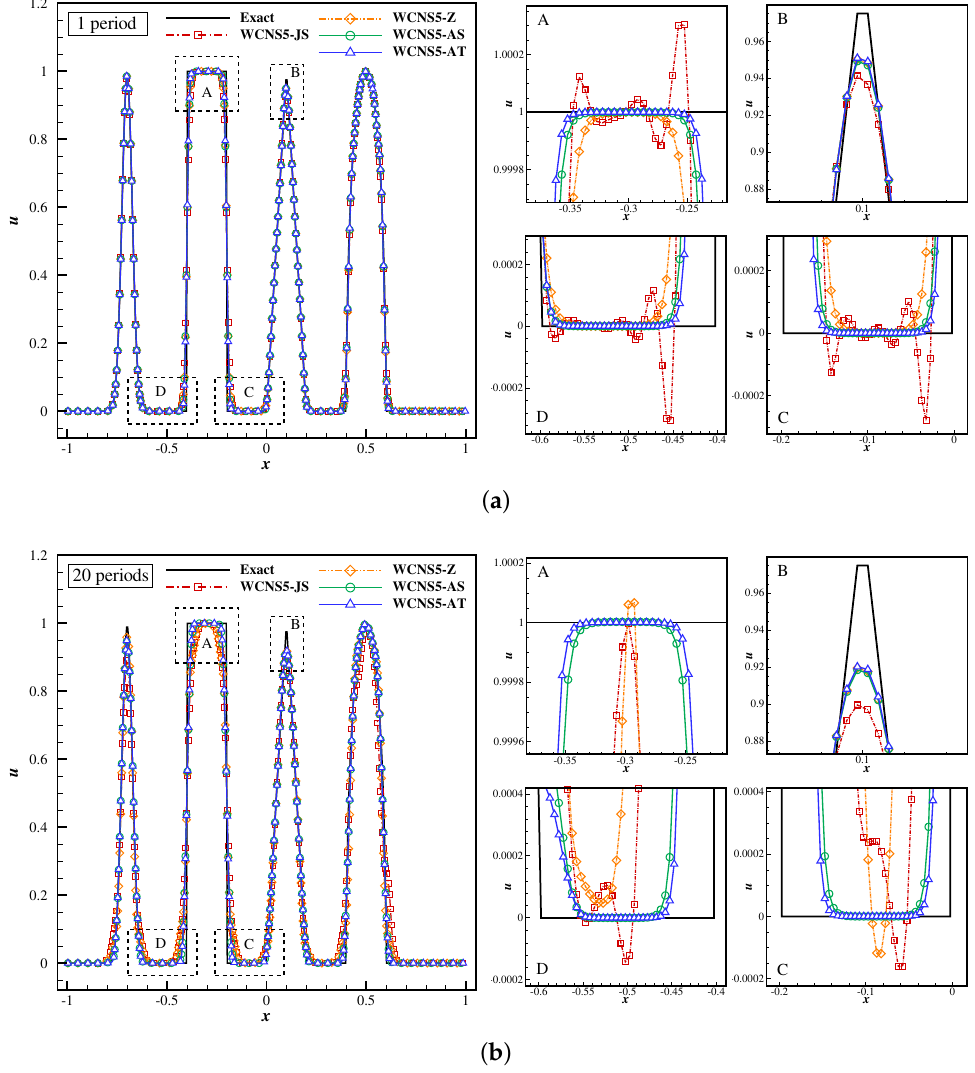
Figure 10. Computational results of composite wave: ( a ) 1 period; ( b ) 20 periods. For 20 advection periods, the waveforms computed using WCNS5-JS and WCNS5-Z are distorted, and large errors arise due to excessive dissipation, while the WCNS5-AT scheme maintains the waveform with the least distortion. This indicates that the WCNS5-AT scheme has the lowest numerical dissipation, which is desirable for long-time